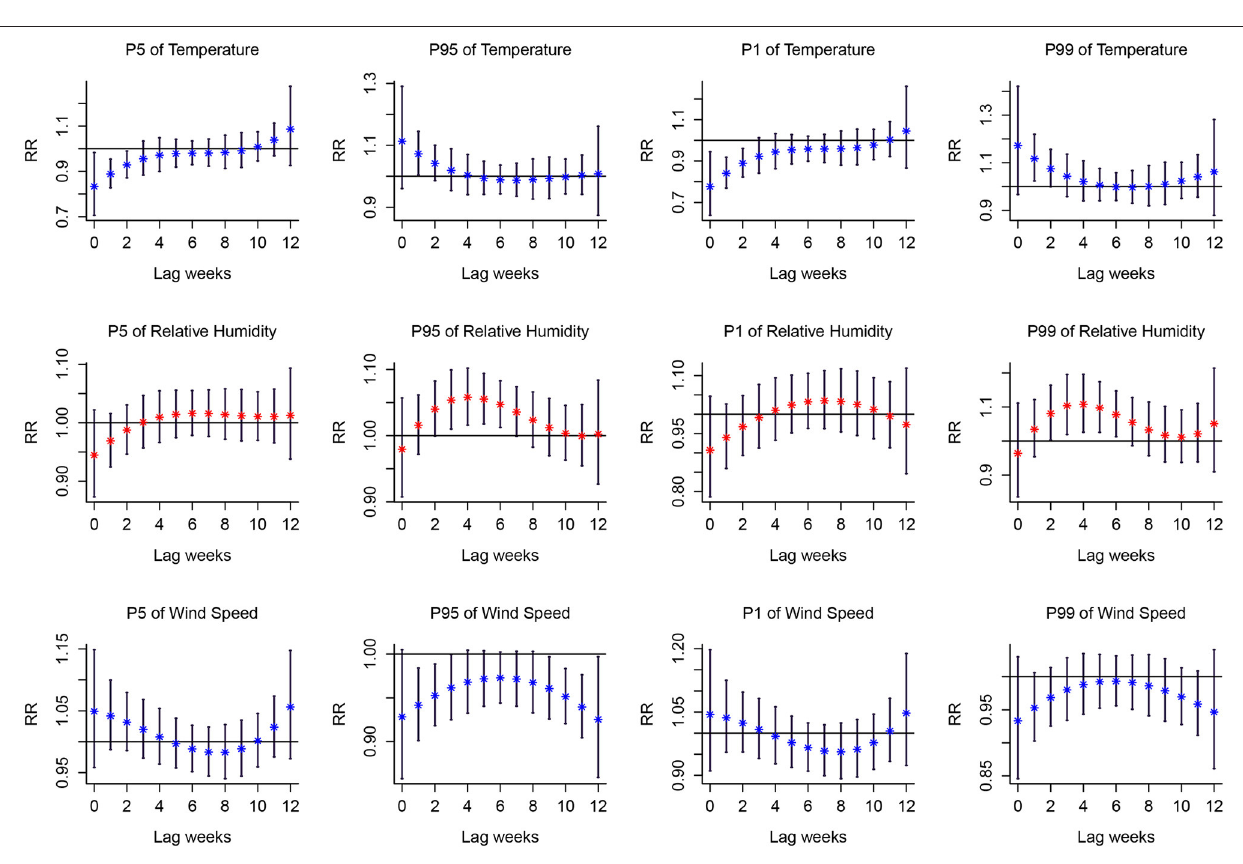
of temperature (RR = 0.416, 95%CI: 0.262–0.659). However, extreme high temperature was found as a risk factor for PTB, with the most significant cumulative effects at the 99th percentile of temperature (RR = 1.675, 95%CI: 1.085–2.587). Extreme high relative humidity increased the incidence rate of PTB in the 99th and 95th percentiles, and it had the most significant